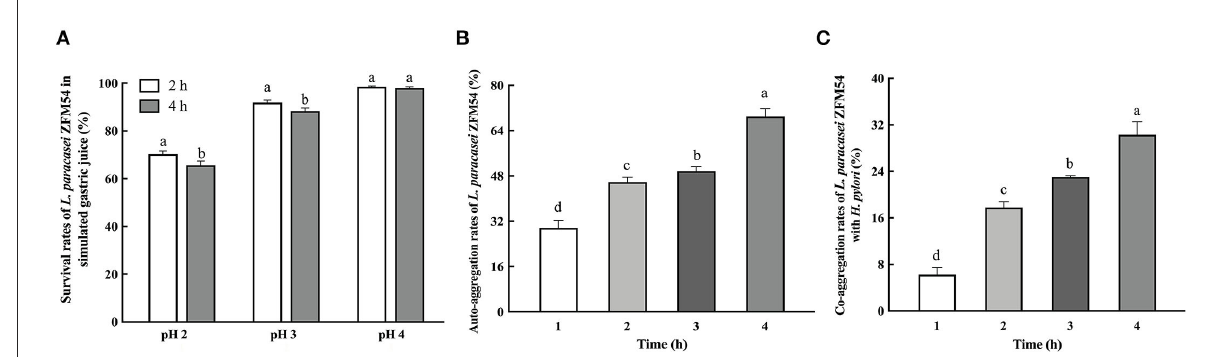
FIGURE2 Tolerance to simulated gastric juice (A) , auto-aggregation rate (B) , and co-aggregation rate (C) of L. paracasei ZFM54. The results are expressed as mean ± standard deviation ( n = 3), and columns with different lowercase letters were significantly different ( p < 0.05) using Tukey’s test.